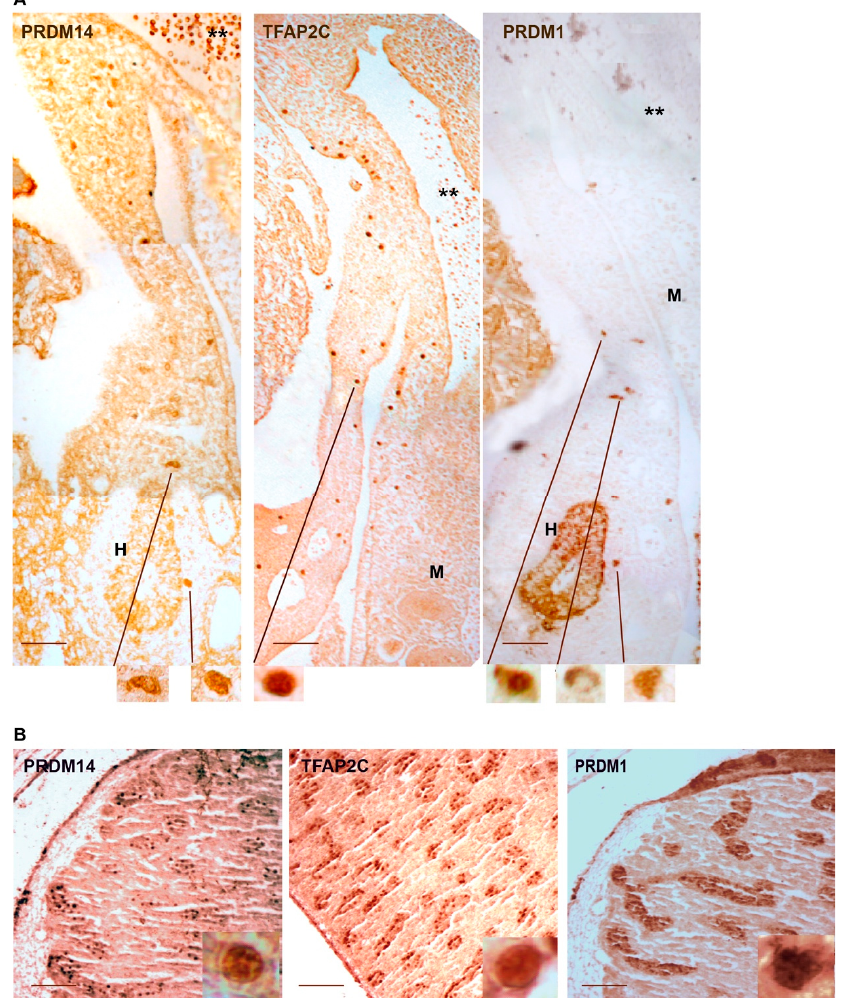
Figure 2. Expression of PRDM14, TFAP2C, and PRDM1 in human germ cells. ( A ) Section of a human embryo at 4 wpc carried at the level of dorsal mesentery and stained for TFAP2C, PRDM14, and PRDM1. Lines point to magnified PGCs captured during migration along the dorsal mesentery that show nuclear PRDM14 or TFAP2C staining while PRDM1 is found in multiple localizations. **—dorsal aorta; H—hindgut; M—mesonephros. ( B ) Fetal testis at 11 wpc stained for PRDM14, TFAP2C, and PRDM1. Insets represent nuclear localization signals in gonocytes. Bars represent 100 μ m. Inset bars represent 10 μ m. Two human fetuses, obtained under informed consent from pregnant women undergoing thera- peutic abortion at 4 and 11 wpc, respectively, at the Dipartimento di Promozione della Salute, Materno-Infantile, Medicina Interna e Specialistica di Eccellenza “G. D’Alessandro” (PROMISE) of the University of Palermo. The ethical committee of the Department of Biomedicine, Neuroscience and Advanced Diagnostics of the University of Palermo, Italy approved the use of human fetal tissue for research purpose. Mouse anti-TFAP2C (sc-12762) was from SantaCruz Biotecnology; Mouse anti-PRDM1 (MA1-16874) and rabbit anti-PRDM14 (PA5-93019) were from Thermofisher. Dako EnVision dual link system-HRP (Agilent) was used to reveal primary antibodies.